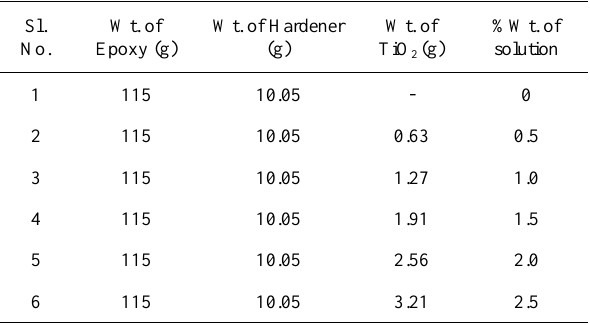
Table 1. Composition of epoxy, hardener and TiO 2 nanoparticles used for the synthesis of polymer composites Sl. No.